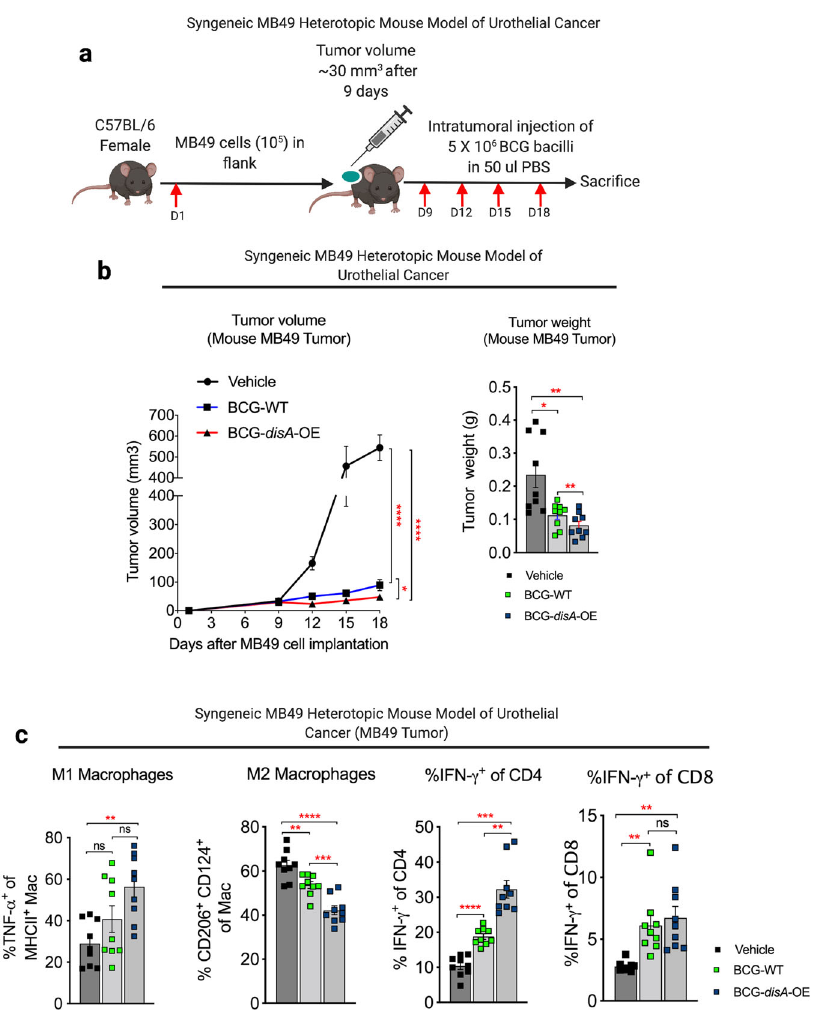
Fig. 6 BCG- disA -OE elicits improved antitumor ef fi cacy over BCG-WT in the syngeneic MB49 heterotopic mouse model of urothelial cancer. a Schematic diagram of the syngeneic MB49 mouse model of urothelial cancer. b MB49 tumor volume and tumor weight at time of necropsy ( n = 9 animals per group). c Tumor-in fi ltrating M1 and M2 macrophages and CD4 and CD8 T-cell lymphocyte types at necropsy in the MB49 model ( n = 9 animals per group). Data are presented as mean values ±S.E.M. Statistical analyses for tumor volume data were done using one-way ANOVA (* P < 0.05, ** P < 0.01, *** P < 0.001, **** P <0.0001). Tumor weight measurement, macrophage, and lymphocyte quanti fi cation done using two-tailed Student ’ s t -test (* P <